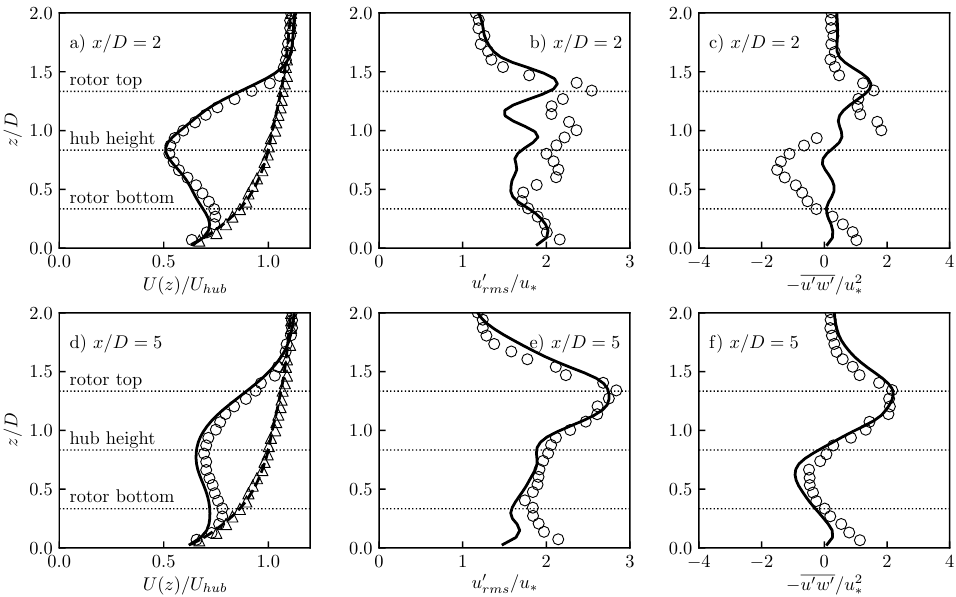
Figure 7. Vertical profiles of time-averaged velocity U ( z ) , turbulence intensity u (cid:48) rms , and time-averaged u (cid:48) w (cid:48) at two different distances downstream of the turbine: subplots ( a – c ) are at x / D = Reynolds stress − 2 and subplots ( d – f ) are at x / D = 5. The results from our LES are denoted by —; the measurement data in wind-tunnel experiment of [44] are denoted by . In ( a , d ), the inflow profiles are plotted for ◦ reference: the LES results of inflow are denoted by ; the wind-tunnel data of upstream flow are −− denoted by . The heights of rotor top, rotor center, and rotor bottom are denoted by (cid:52) · · ·